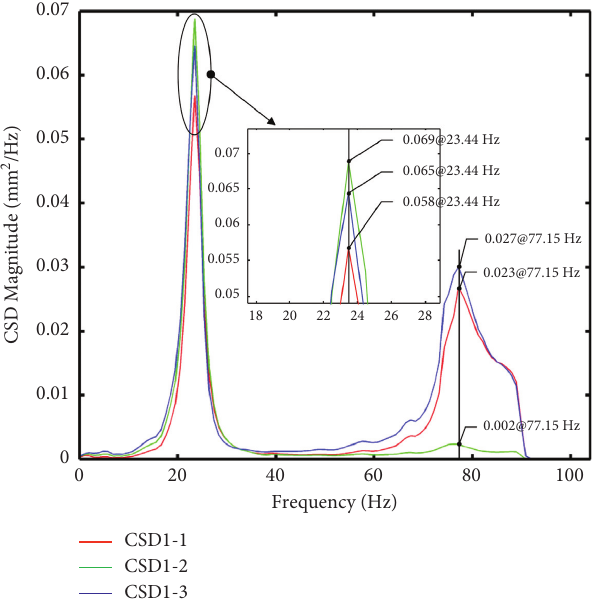
Figure 7: Magnitude curve of the power spectrum.